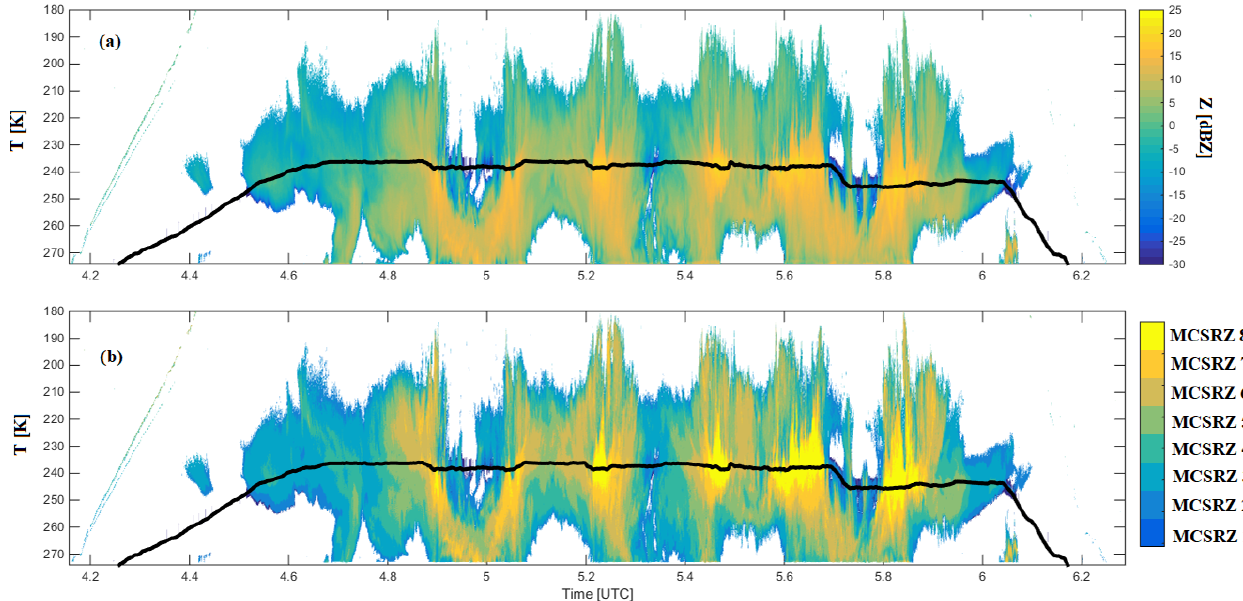
Figure 2. (a) Time series of cloud radar profiles of flight 13 of HAI-HIWC over Darwin. Z color coded in dBZ and plotted as a function of the temperature ( y axis). (b) Similar to (a) with Z classified according to altitude-dependent Z percentile